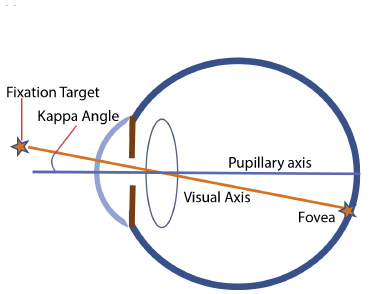
Figure 1. Axial diagram with an approximation of the human eyeball model. The image corresponds with a top-view of a left eye. Considering a fixation target, we could distinguish between the visual axis and the pupillary axis. The kappa angle establishes the relation between the two axes. Original image from [27].